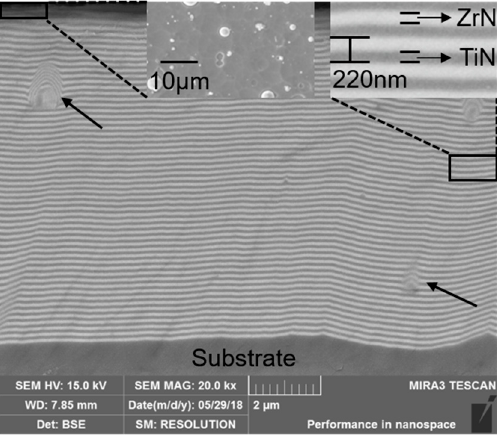
Figure 3. Sectional morphologies of the TiN/ZrN multilayer coatings.